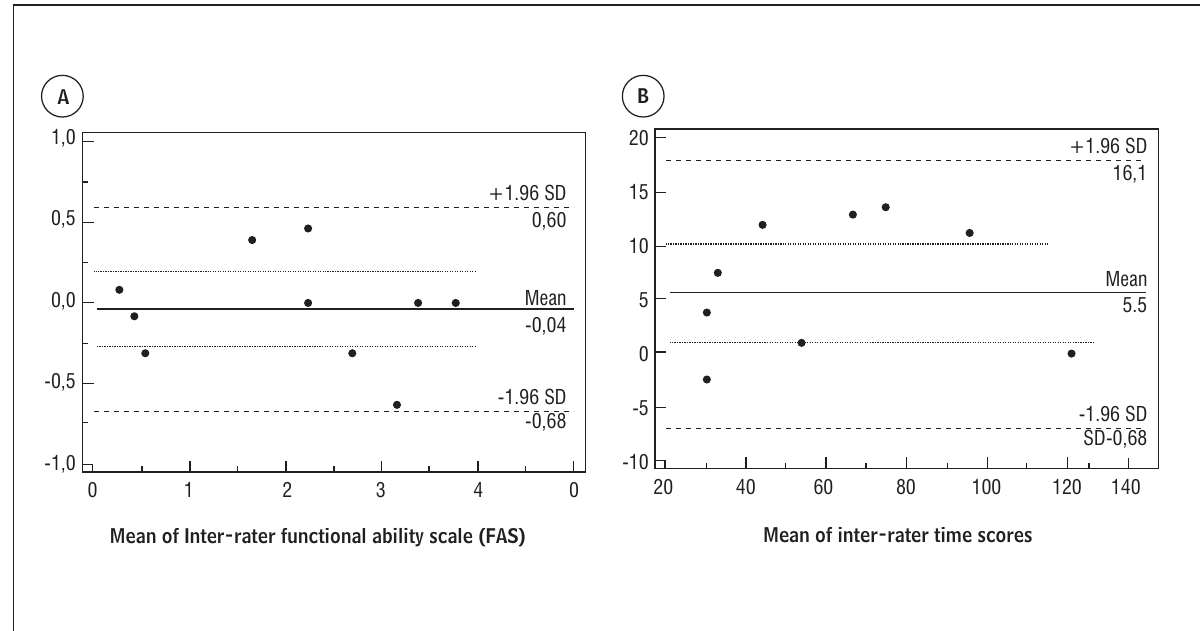
Figure 1 - Scatter-plots of the differences between the two GWMFT measurements and mean of total individual scores. A = Inter-rater Functional Ability Scale (FAS) scores; B = inter-rater time scores. The middle horizontal continuous black lines indicate the mean differences and the confidence intervals are presented in gray dotted line. The black dotted lines (more distant) indicate the upper and lower limits of